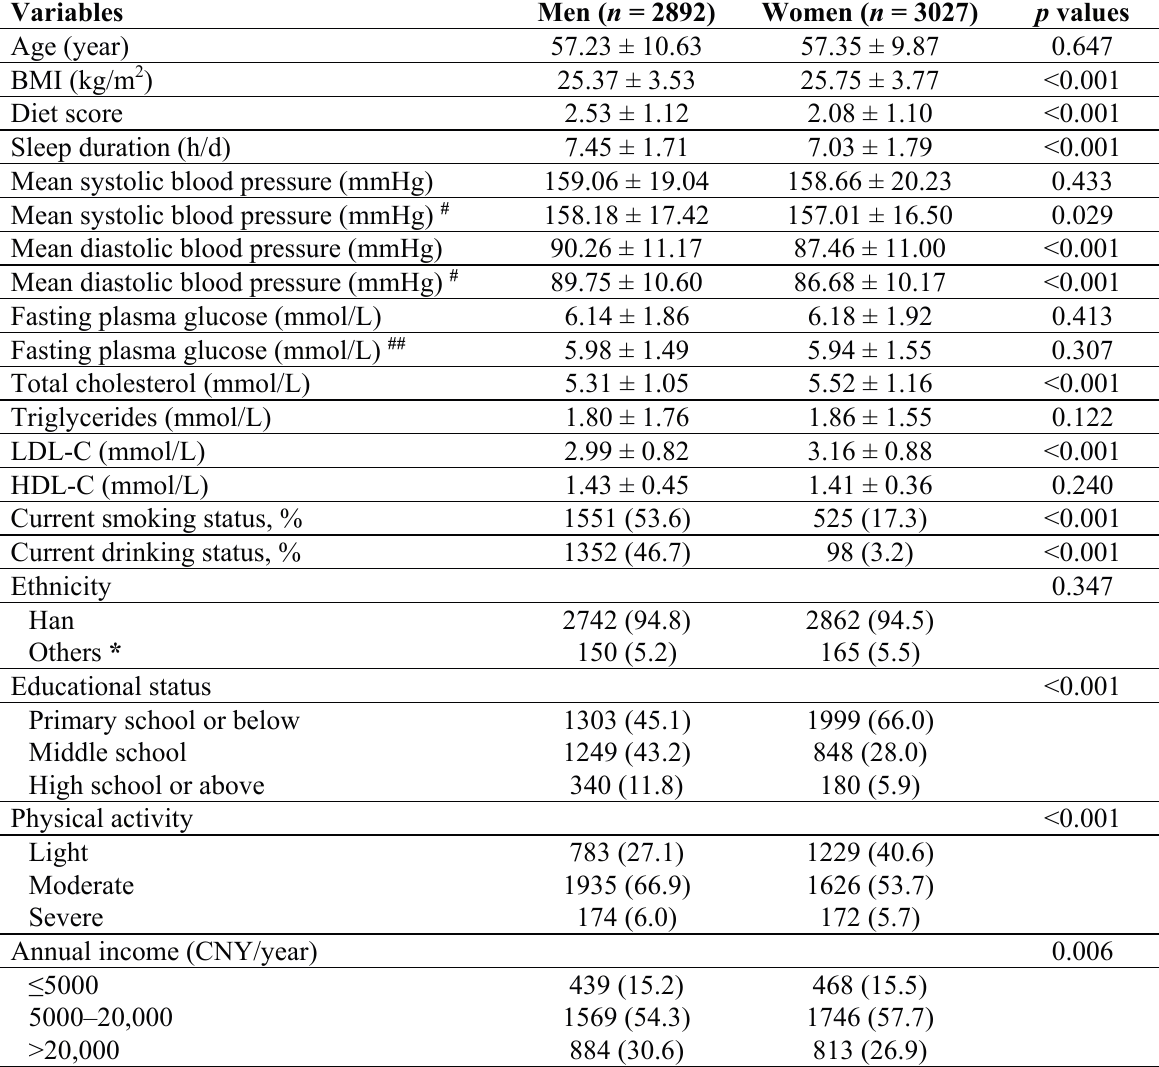
Table 1. Demographic and anthropometrical characteristics of the study